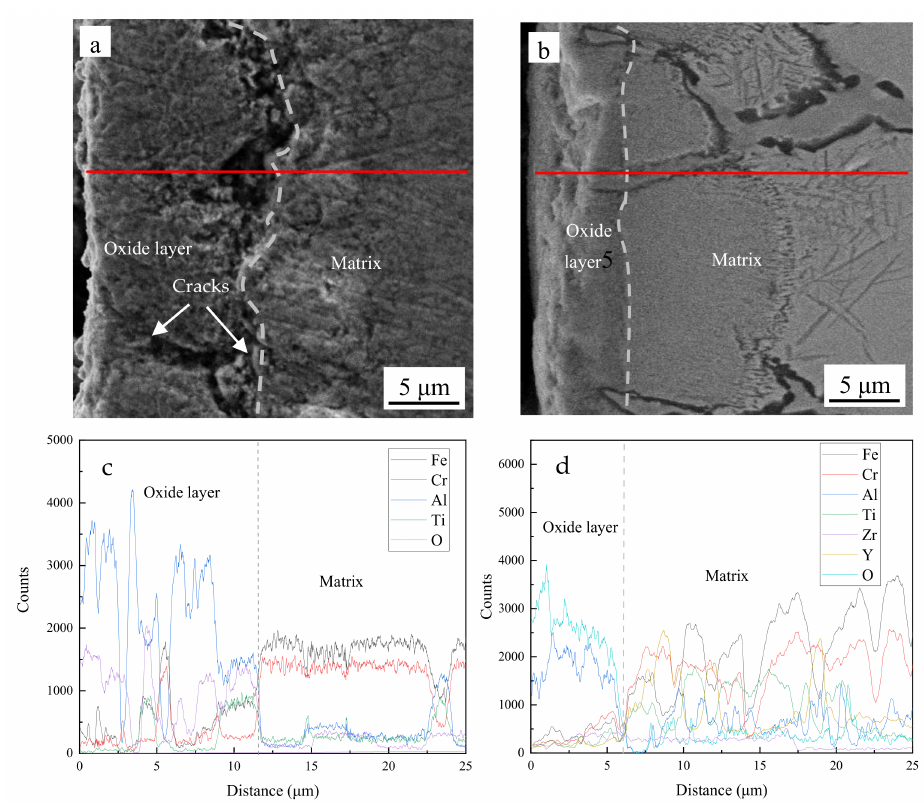
Figure 4. SEM and EDS line of Fe-Cr-Al specimen ( a , c ), and Fe-Cr-Al ODS specimen ( b , d